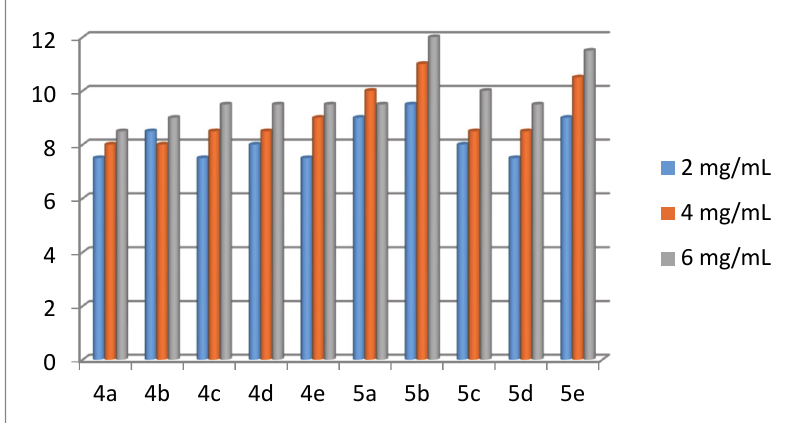
Figure 3. Graphical presentation of inhibition zone diameter (mm) against Klebsiella.